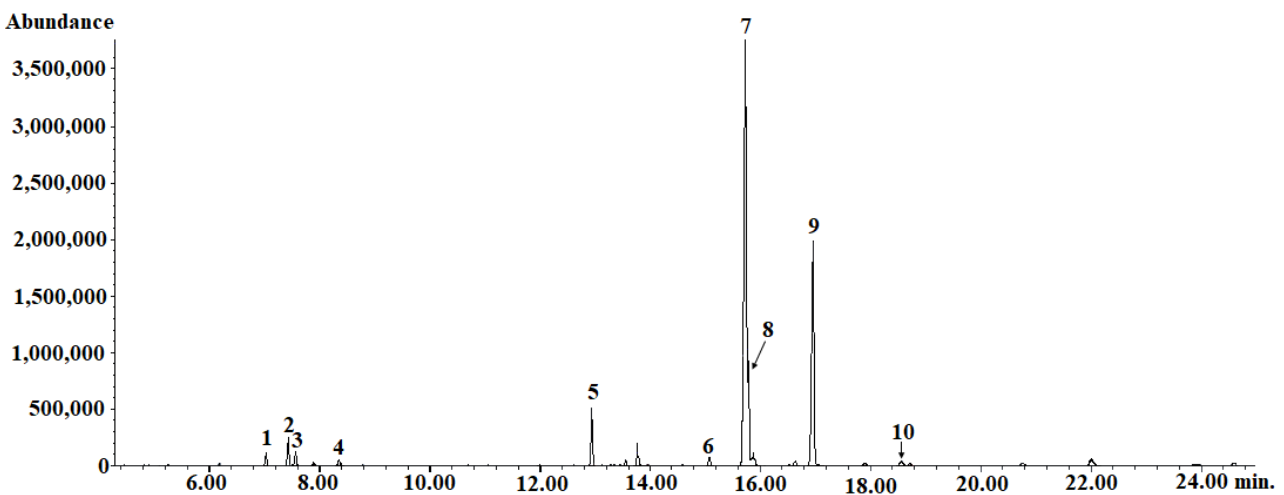
Figure 9. GC–MS chromatogram of Eleutherococcus senticosus fruit oil. 1-(Z)- β -farnesene; 2- α -bergamotene; 3- α -farnesene; 4- β -cubebene; 5-methyl palmitate; 6-methyl stearate; 7-trimethylsulfonium ursolate; 8-methyl oleate; 9-methyl linoleate; 10-methyl linolenate. HP-88 Agilent 45 capillary column (60 m × 0.25 mm; 0.20 µ m film thickness). The oven temperature was programmed from 110 ◦ C to 190 ◦ C with 8 ◦ C/min held for 2 min at 110 ◦ C and 13 min at 190 ◦ C. The temperature of the injector was 250 ◦ C. Helium was used as a carrier gas at a flow rate of 1.2 mL/min A quadrupole mass spectrometer with electron ionization (EI) at 70 eV and with a full scan type acquisition mode (50 m/z to 500 m/z ) was used as a detector connected with GC. The temperature of the MS source and the MS quadrupole was set to 230 ◦ C and 150 ◦ C, respectively.